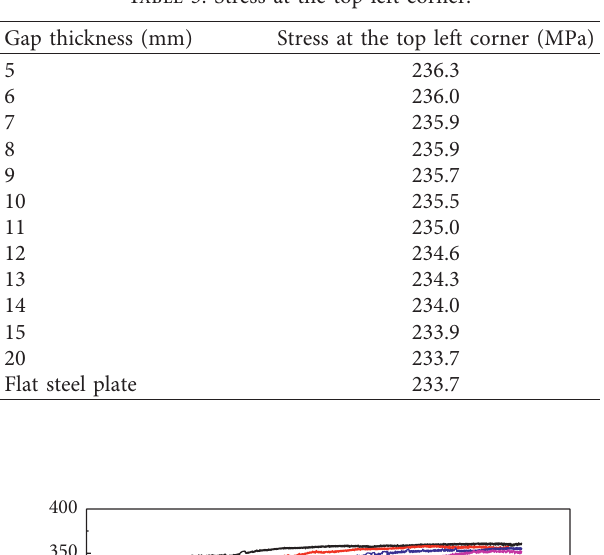
Table 3: Stress at the top left corner.